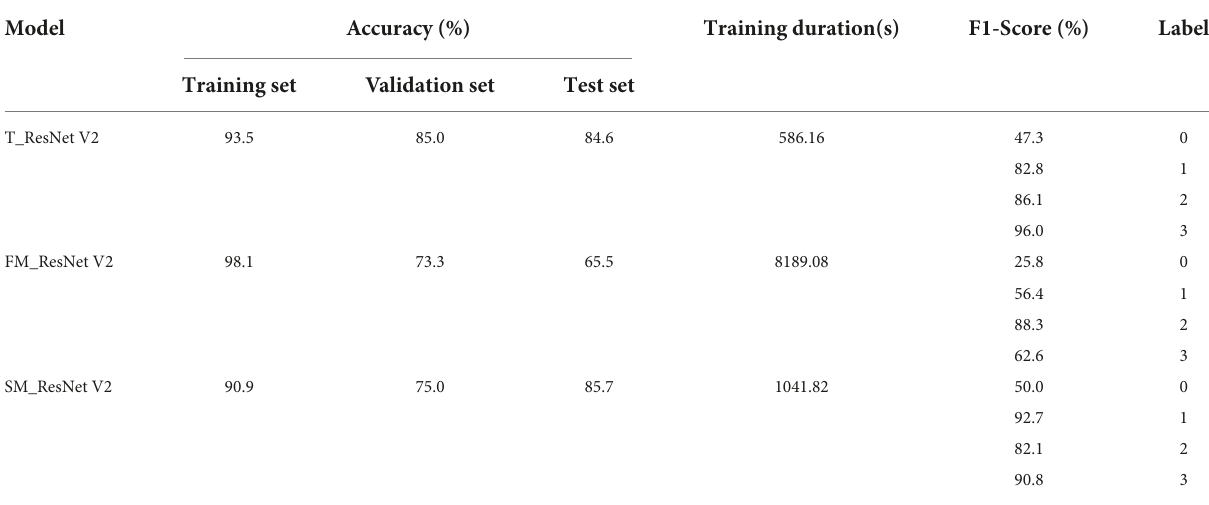
TABLE 4 The accuracy, training time, and F1-score of the three models. Model Accuracy (%) Training duration(s) F1-Score (%)